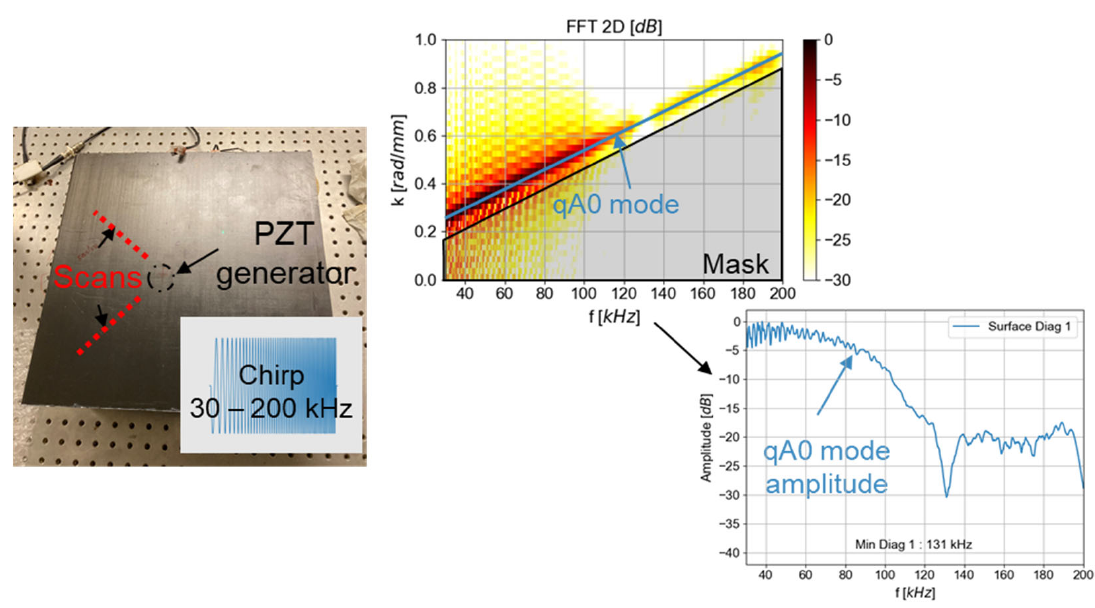
Figure 10. Methodology of qA0 mode excitation extraction (400 × 400 mm 2 plate).